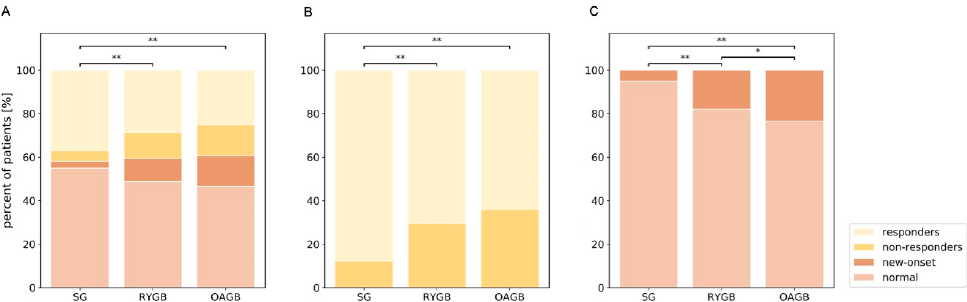
Figure 2. Sleeve gastrectomy has a higher probability for normalizing ALT levels and preventing new onset of abnormal ALT levels. ( A ) The percentage of patients who started with high levels of ALT and experienced a reduction to normal ALT levels (responders), started and remained with abnormal levels of ALT (non-responders), started with normal ALT levels that increased to abnormal levels (new-onset) or started and remained within the normal range (normal). Dark shades denote patients with abnormal ALT levels two years after surgery. n = 4144 SG; 498 RYGB; 338 OAGB. ( B ) Percentage of patients who started with abnormal levels of ALT and experienced a reduction to normal range (responders) or remained at abnormal ALT levels two years after surgery (non-responders). n = 1741 SG; 202 RYGB; 133 OAGB. ( C ) Percentage of patients whose ALT levels increased from normal to abnormal levels (new-onset), or started with normal levels of ALT and remained at normal range (normal). n = 2403 SG; 296 RYGB; 205 OAGB. ** p < 0.001, * p < 0.05 using χ 2 test. SG: Sleeve Gastrectomy; RYGB: Roux en Y Gastric Bypass; OAGB: One Anastomosis Gastric Bypass; ALT: Alanine Aminotransferase.